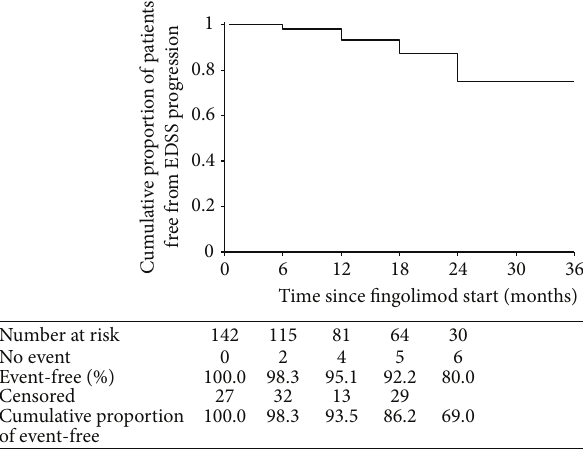
Figure 4: Kaplan-Meyer plot of cumulative proportion of patients remaining free from new or newly enlarging T2 lesions over time from start of fingolimod therapy.